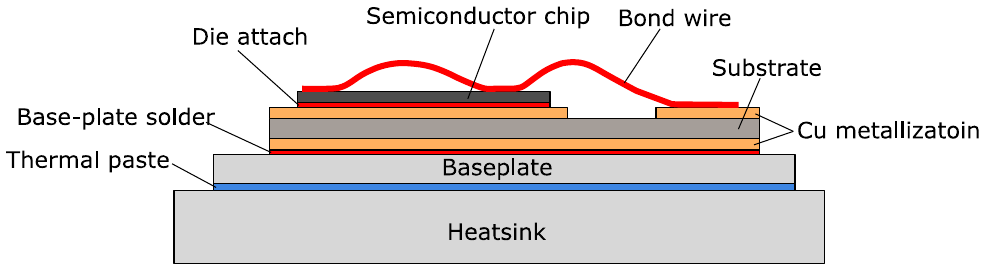
Figure 1. Cross-section of an insulated gate bipolar transistor (IGBT) module including the connected heatsink.